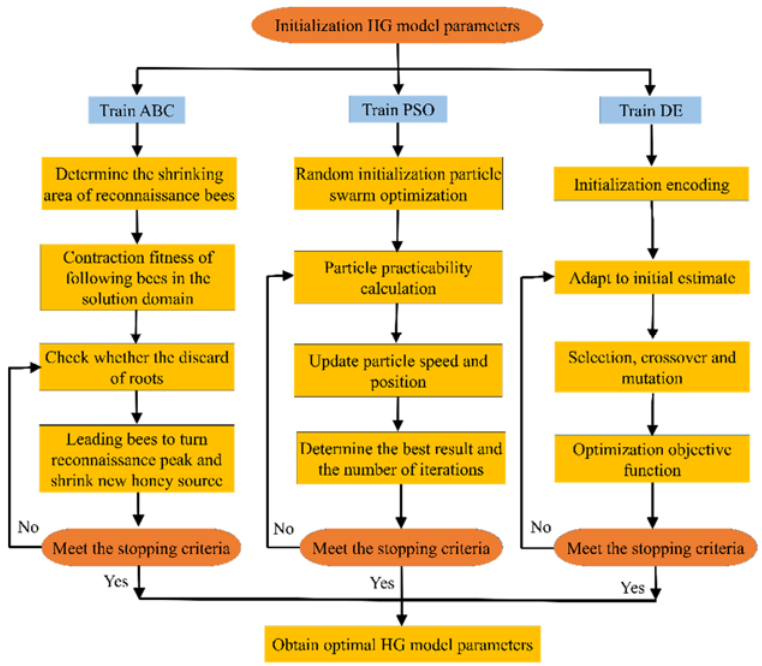
Figure 2. The flow chart of ABC, DE and PSO optimization methods process.